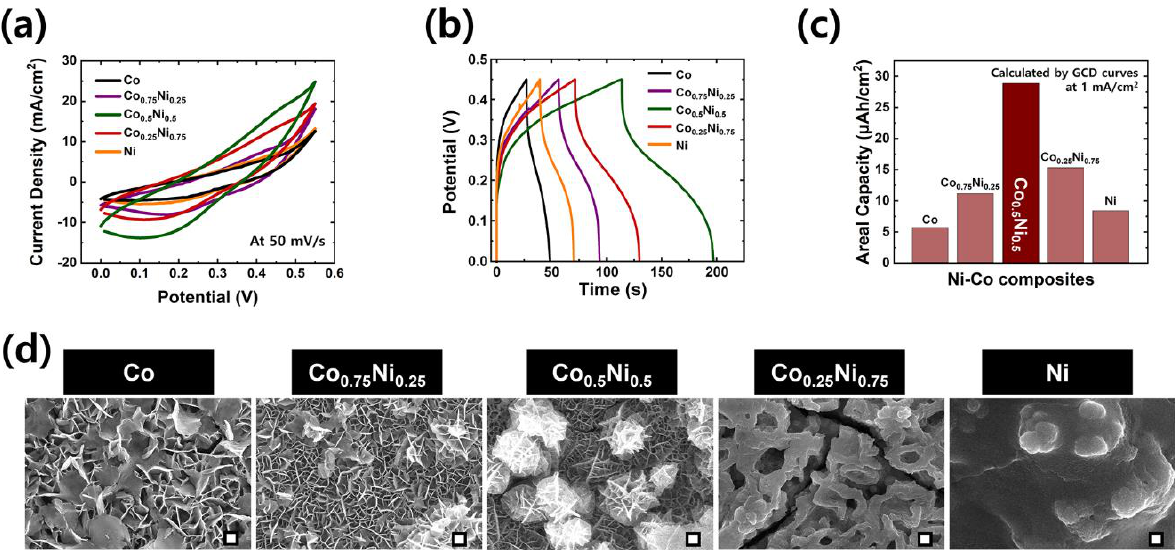
Figure 3. Optimization of ratios of Ni and Co in composites (Ni-Co LDHs). Comparisons of electrochemical performance for various compositions of NiCo-LDHs (Co, Co 0.75 Ni 0.25 , Co 0.5 Ni 0.5 , Co 0.25 Ni 0.75 , and Ni) through ( a ) CV (at 50 mV/s), ( b ) GCD (at 1 mA/cm 2 ), and ( c ) the calculated areal capacity values from the obtained GCD results. ( d ) Comparisons of surface morphology of all compositions by FE-SEM characterization (all scale bars demonstrated in the SEM images indicate 200 nm.).